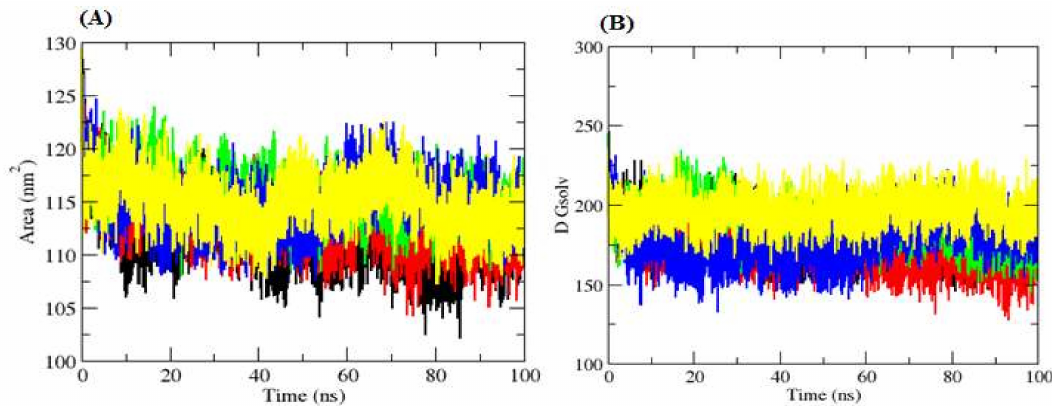
Figure 6. Solvent Accessible Surface Area. ( A ) The SASA plot. ( B ) The free energy of solvation. The Black, red, green, blue, and yellow color represent values obtained for Mrlip1, Mrlip1-RHC80267, Mrlip1-ZINC85530919, Mrlip1-ZINC95914464, and Mrlip1-ZINC85530320